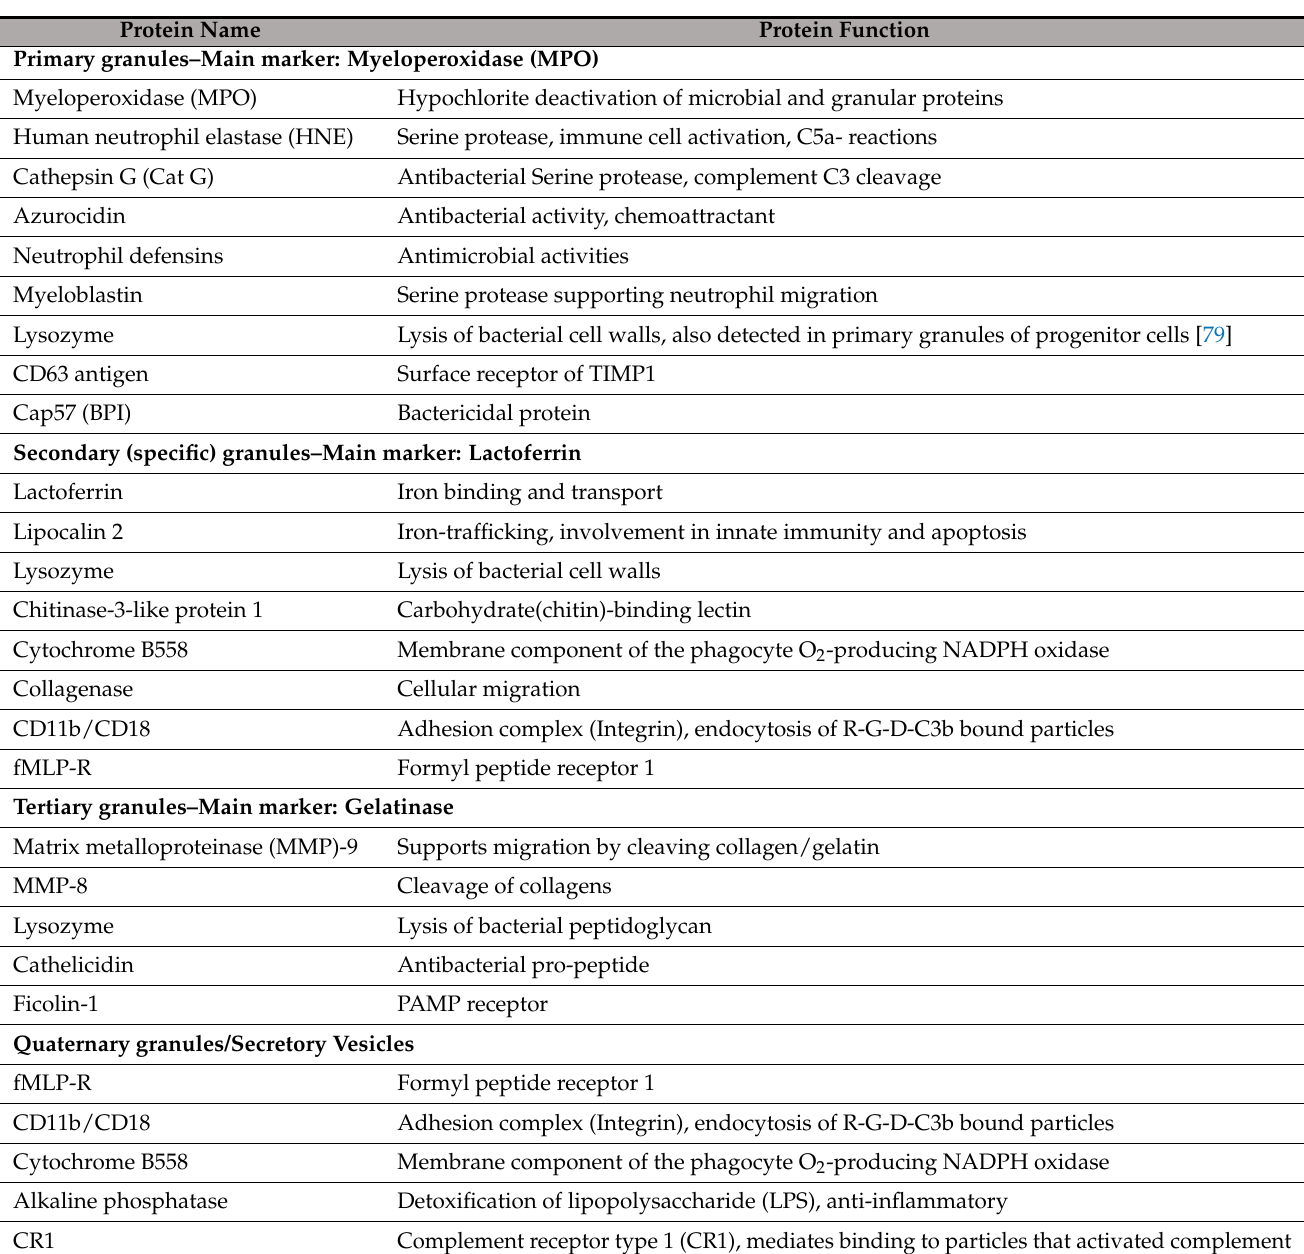
Table 1. Abundant human granule proteins